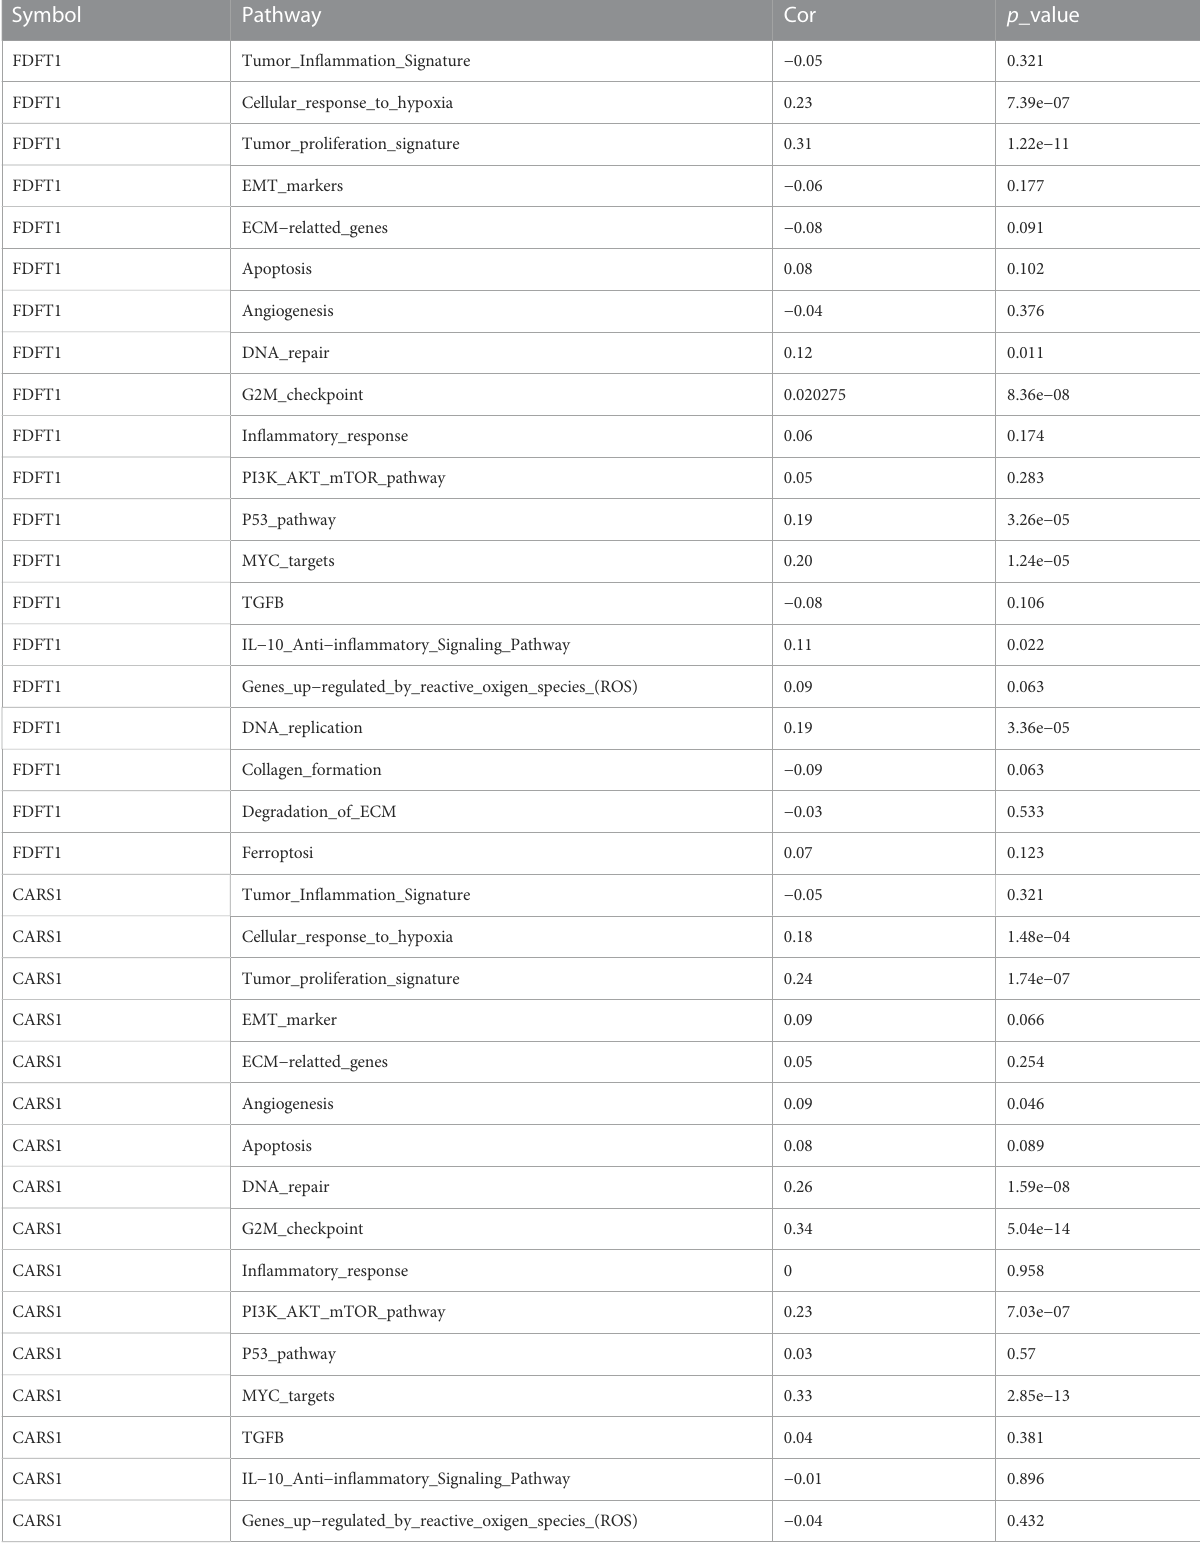
TABLE 1 Pathways correlated to FGRs genes in